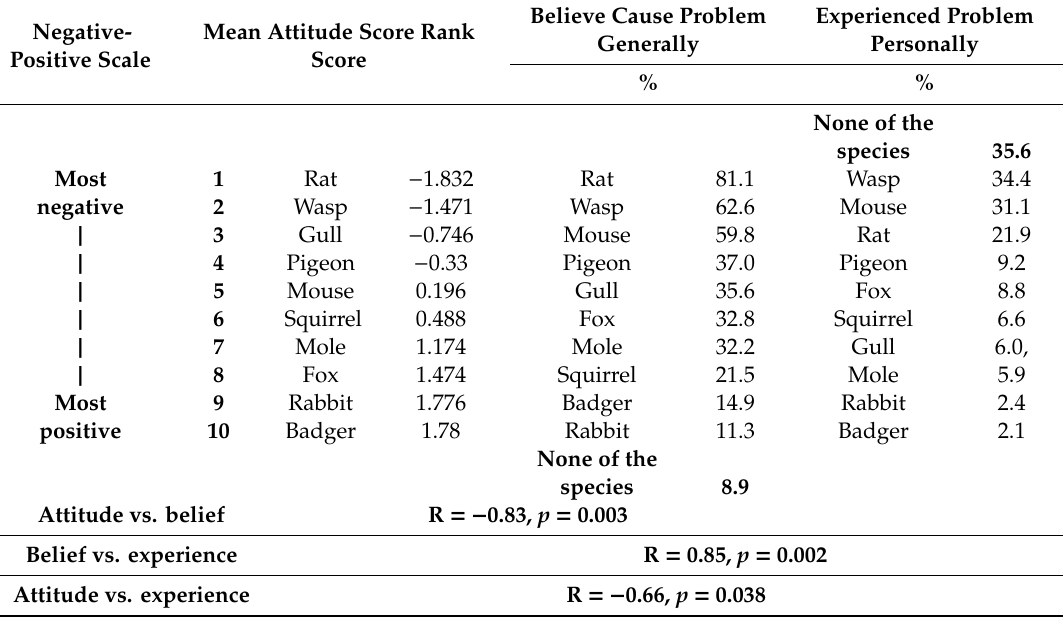
Figure 1. Mean attitude scores for each of the 10 species ( n = 2000). Bars above the line represent positive attitudes and those below the line represent negative attitudes. Greater scores indicate more positive attitudes. Table 1. Species ranked by positive mean attitude score and by the percentage of people reporting that the species had caused them a problem personally and the percentage believing that the species causes problems for people generally in the UK ( n = 2000). Greater attitude scores indicate more positive attitudes.